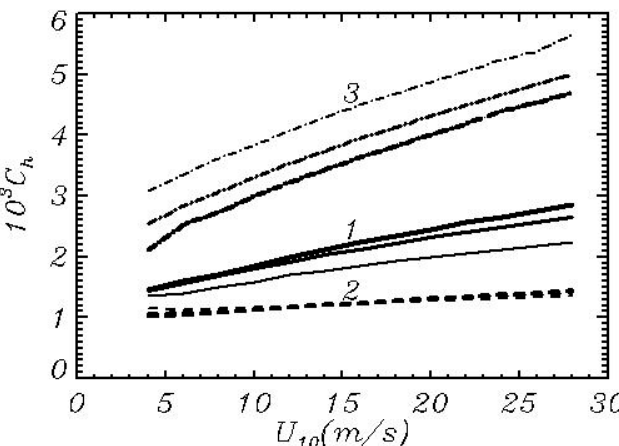
C on wind velocity U for different angles between a 10 10